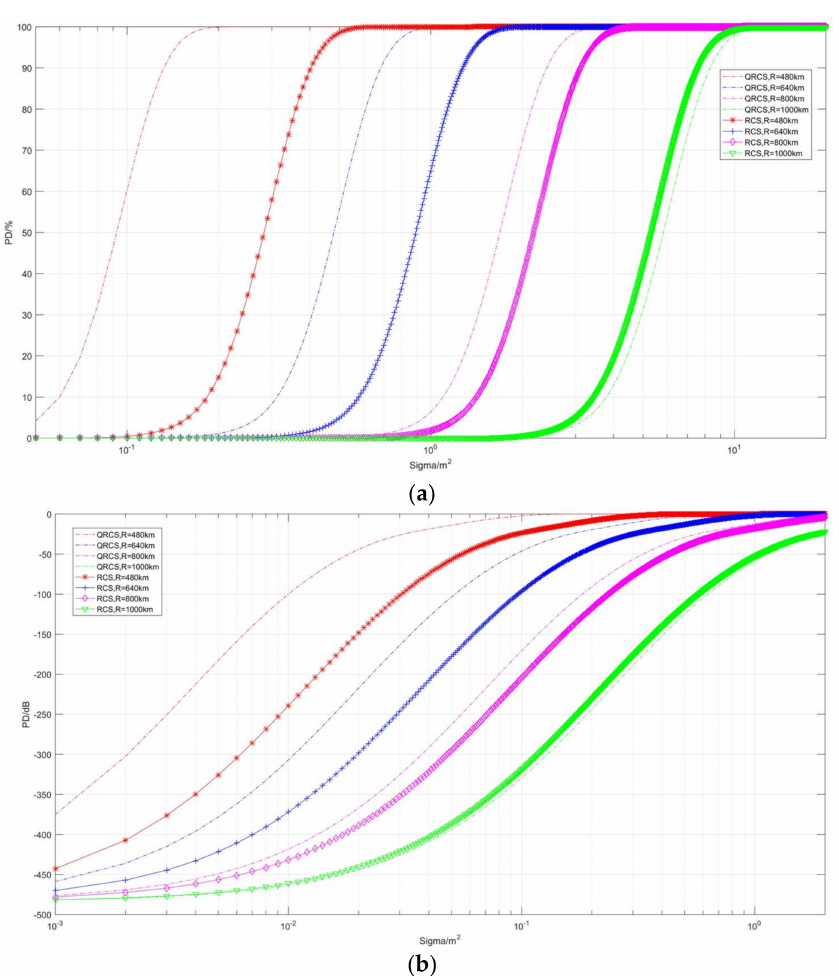
Figure 13. Correlation diagram of detection probability changing with RCS and QRCS (Taking different distances). ( a ) P D /%, ( b ) P D /dB.